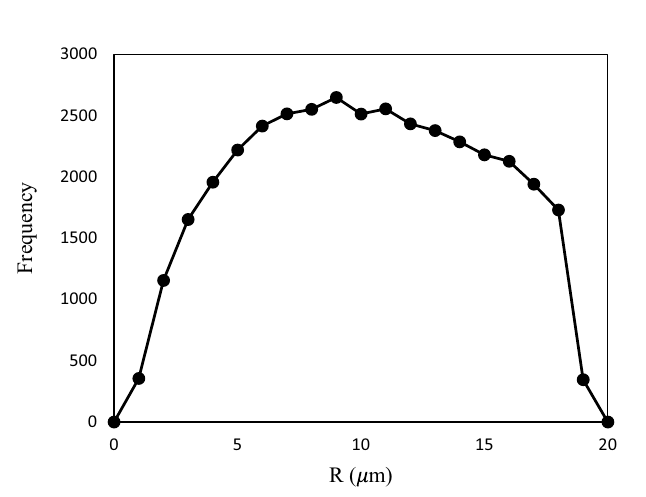
Figure 7. Throat size